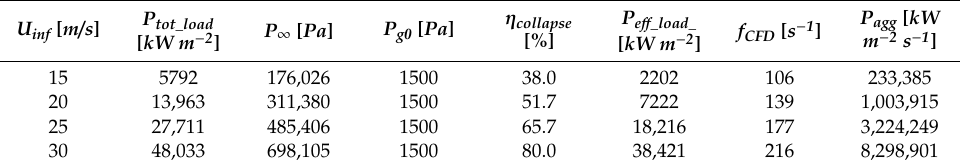
Table 4. Numerically calculated indicators of cavitation erosion for di ff erent flow velocities. U inf [ m / s